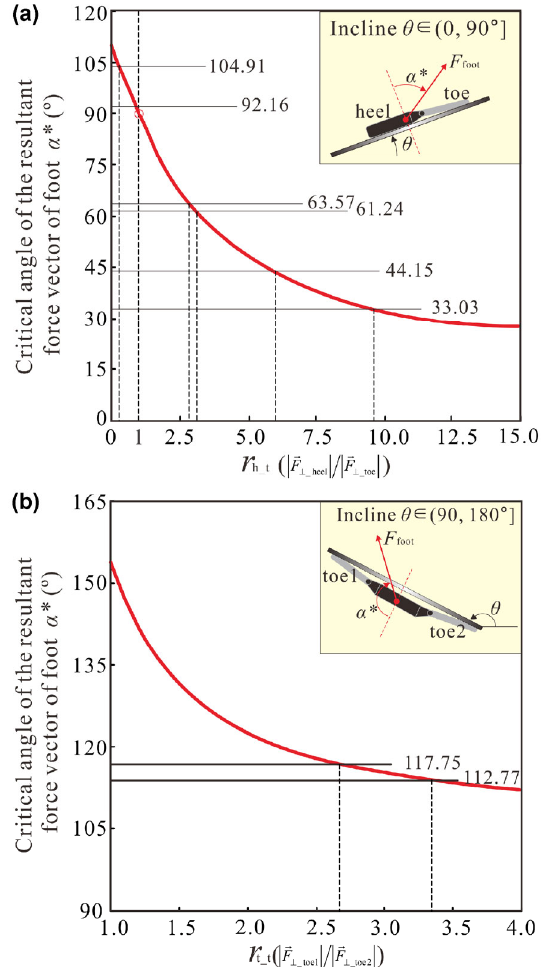
Fig. 6 Critical angle ( α * ) of the resultant force vector of the foot, calculated by the mechanical model of contact between the foot and the substrate. F foot : the resultant force vector acting on foot. (a) The critical angle of the foot as calculated by the me- chanical model when the incline does not exceed 90°. The average value of α * for the front and hind feet on inclines not exceeding 90°, as measured by experiment, were shown to be level lines in the figure (detail data in Table 1). (b) The critical angle of the foot as calculated by the mechanical model when the incline exceeds 90°. The maximum and minimum average value of α * for the feet, as measured by experiment, are shown in the figure for inclines exceeding